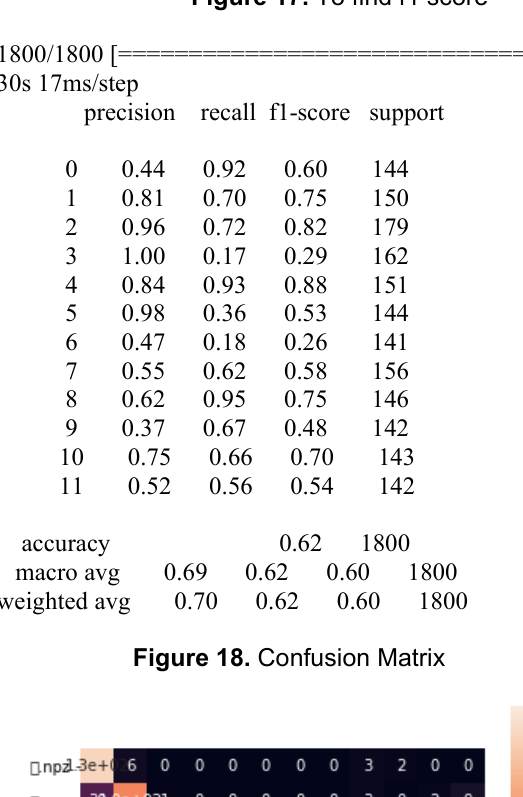
Graph 4. Finding validation loss and model loss Figure 17. To find f1 score